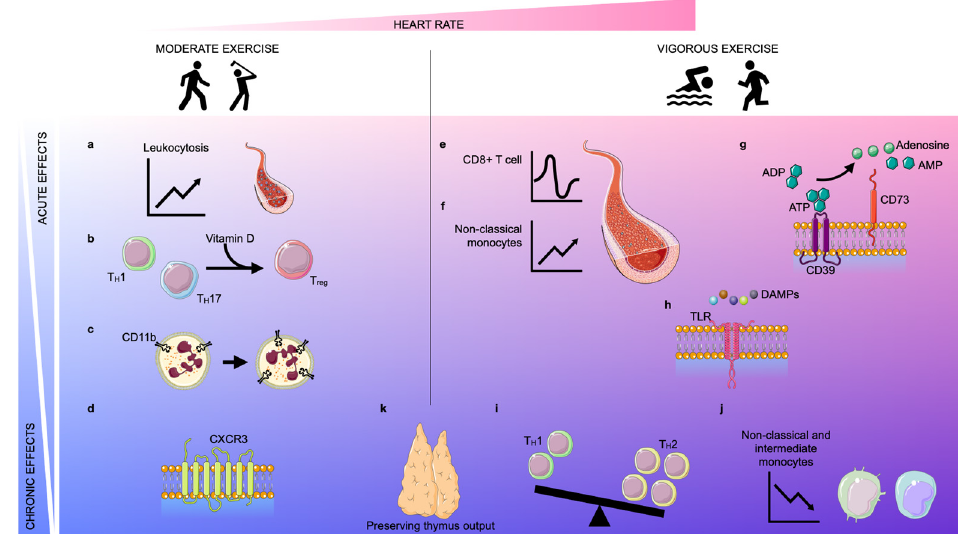
Figure 1. Acute and chronic effects of moderate and vigorous exercise . Depending on the increase in heart rate (pink area), exercise can be classified as moderate exercise or vigorous exercise. The effects of exercise can be classified as acute (light blue area) or chronic (blue area). Acute moderate exercise induces a leukocytosis in the blood ( a ) and a transient upregulation of the intracellular vitamin D receptor (VDR) in T lymphocytes, inducing T cell phenotype switching ( b ). Further, moderate exercise enhances the expression of CD11b on neutrophils acutely and chronically ( c ). In the long term, physical exercise improves the trafficking behavior of both CD8+ cells and natural killer (NK) cells by regulating the expression of CXCR3 ( d ). Vigorous exercise induces alterations in lymphocyte numbers in a biphasic way: an instantaneous lymphocytosis is followed by transient lymphopenia ( e ). Further, non-classical monocytes are increased during exercise ( f ). Vigorous exercise acutely elevates the expression of CD39 and CD73 on CD4+ T lymphocytes which assist in the conversion of adenosine triphosphate (ATP)/adenosine diphosphate (ADP) into adenosine monophosphate (AMP)/adenosine, respectively ( g ). Vigorous exercise reduces the expression of Toll-like receptors (TLRs) 1, 2, and 4 on CD14+ monocytes in the early post-exercise period, inducing anti-inflammatory effects ( h ). In the long term, exercise also promotes anti-inflammatory effects by encouraging anti-inflammatory phenotype switching in lymphocytes and monocytes. The balance between T H 1 and T H 2 cells shifts in favor of T H 2 ( i ) and the frequency of intermediate and non-classical monocytes decreases due to diminished expression of CD16 ( j ). Finally, both moderate and vigorous exercise preserve thymic output ( k